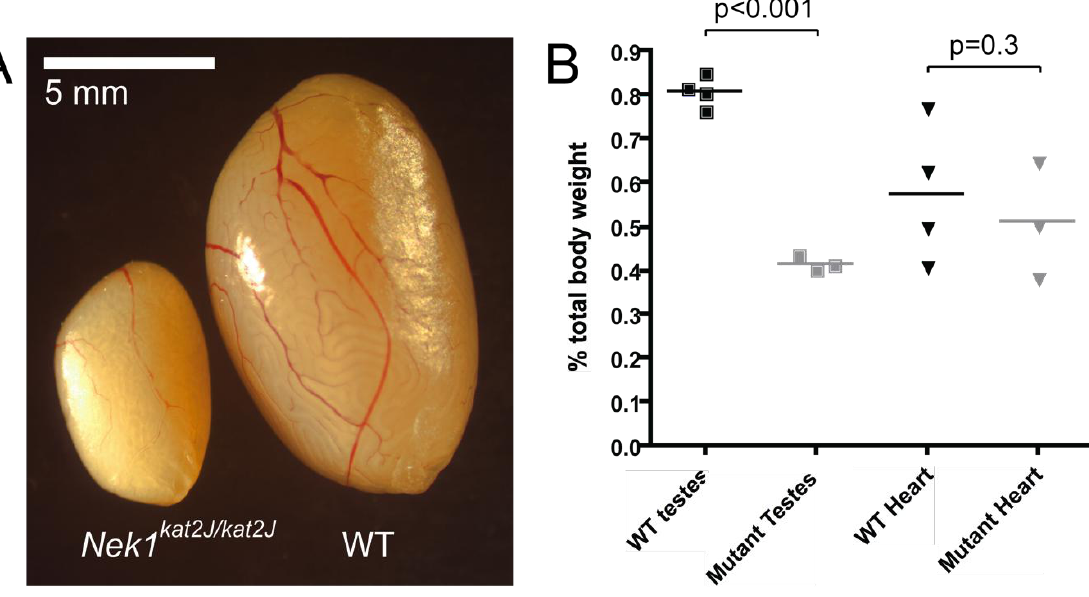
Figure 1. Nek1 kat2J/kat2J mice show decreased testes size. ( A ) Photograph of both Nek1 kat2J/kat2J and wild type littermate testis; ( B ) Wild type (black) and mutant Nek1 kat2J/kat2J (gray) testes and heart sizes, shown as a percentage of total body